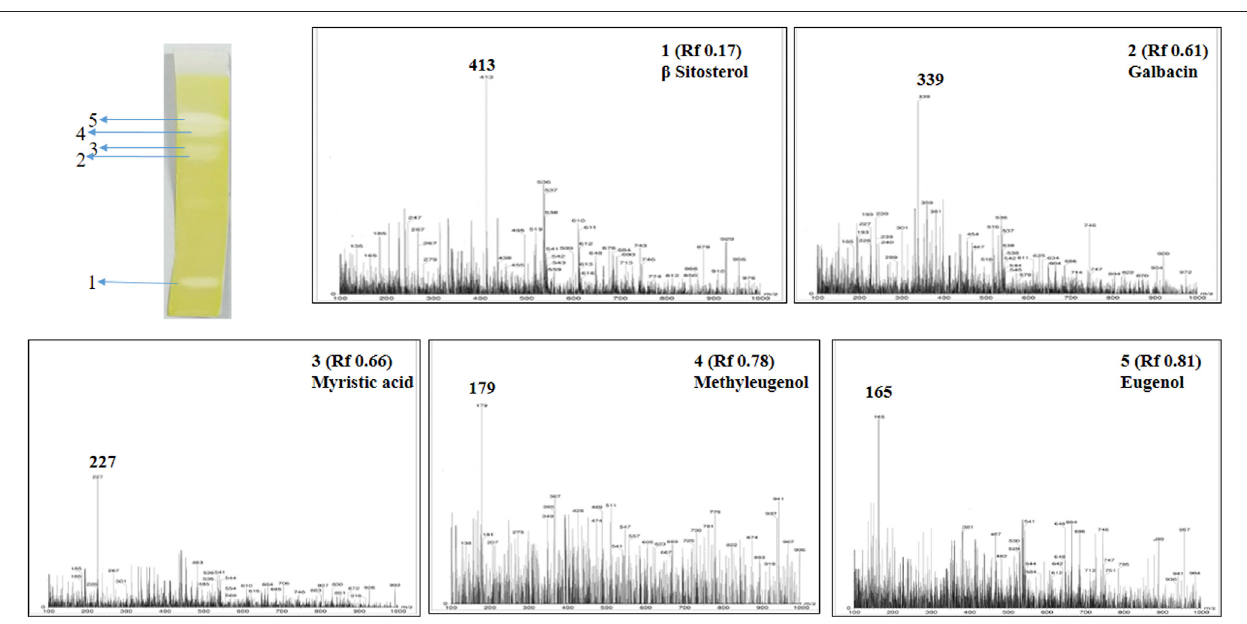
FIGURE 4 | Developed TLC-bioautography plates of MFA represents AChE active spots and their mass spectroscopy.